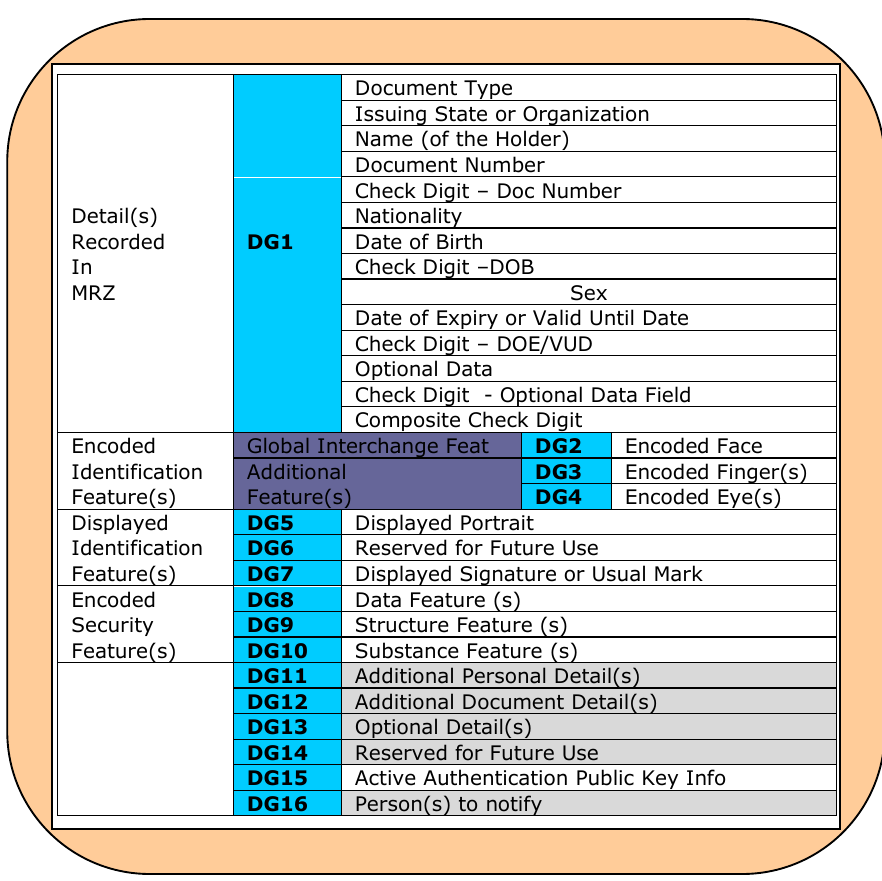
FIGURE 3. The data structure stored in the IC chip of the e-Passport[8].